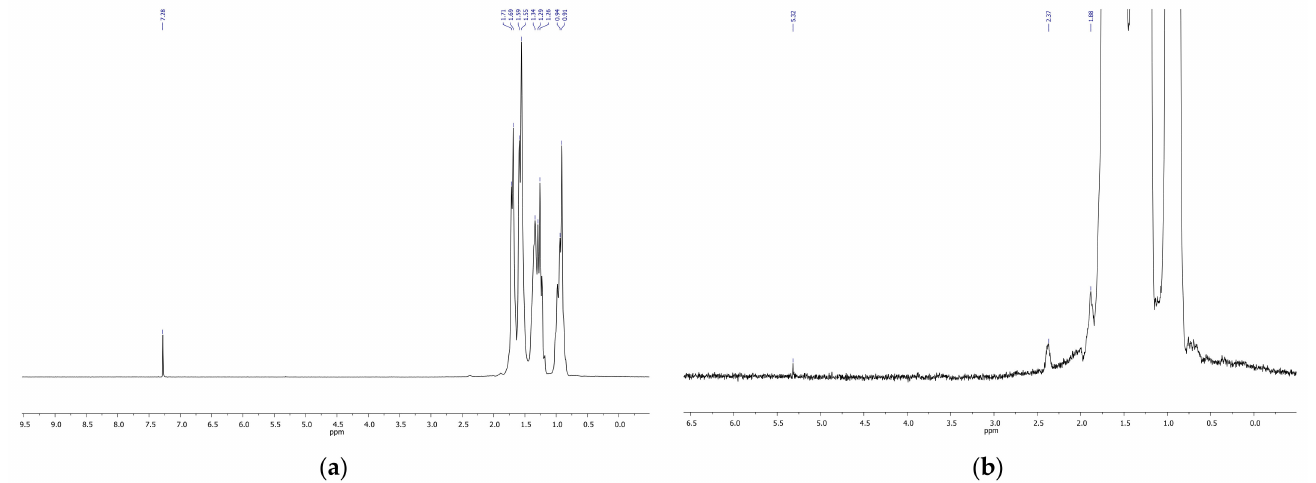
Figure 8. 1 H-NMR spectrum of the mixture of cis and trans-decalins after ozonation for 15 min in a wide range of chemical shifts ( a ) and in the narrow range of 0–6 ppm ( b ).